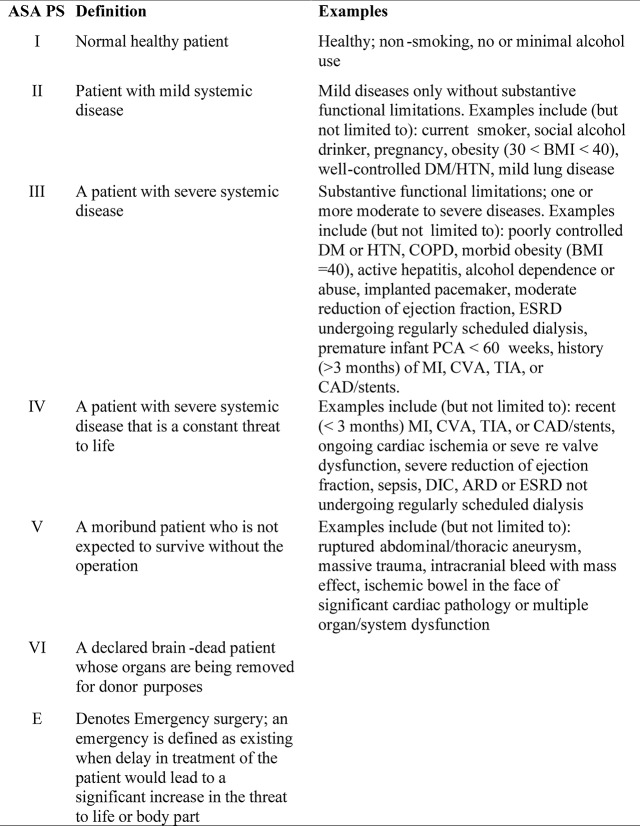
Current American Society of Anesthesiologists Physical Status (ASA PS) classification with definitions published in 1963 (4) and examples accepted in 2014 (9). BMI, body mass index; DM, diabetes mellitus; HTN, hypertension; COPD, chronic obstructive pulmonary disease; ESRD, end-stage renal disease; PCA, patient-controlled analgesia; MI, myocardial infarction; CVA, cerebrovascular accident; TIA, transient ischemic attack; CAD, coronary artery disease; DIC, disseminated intravascular coagulation; ARD, airway respiratory disease.